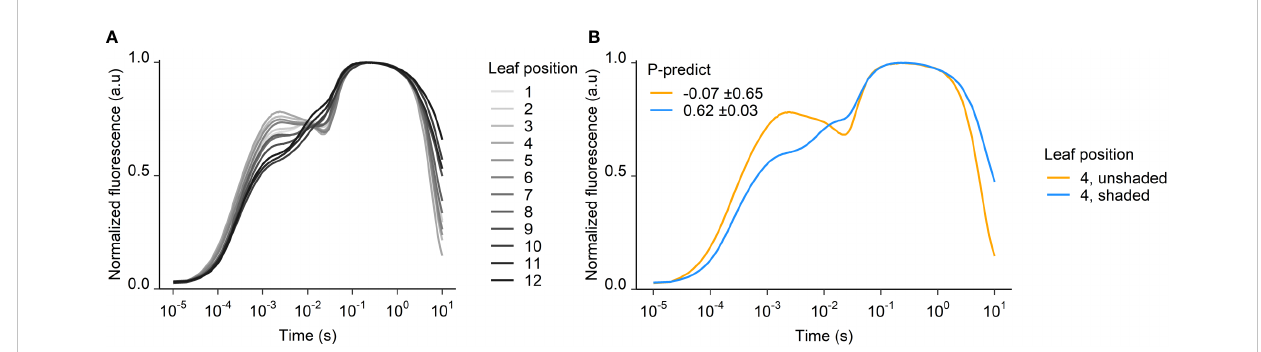
FIGURE 4 Fluorescence transients from 58 DAP at (A) different leaf positions and (B) shaded and unshaded YFEL. P-predict ± SEM is inserted for shaded and unshaded leaves in (B) (n =